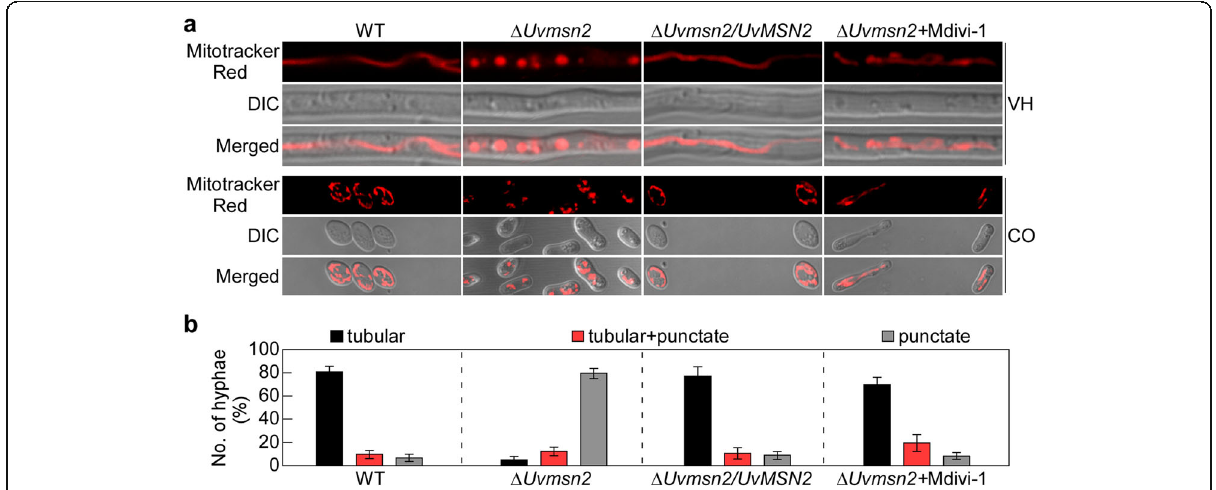
Fig. 6 UvMsn2 is important for the maintenance of mitochondrial morphology in Ustilaginoidea virens . a Confocal microscopic observation of mitochondria in hyphae and conidia of HWD-2, Δ Uvmsn2 and Δ Uvmsn2 / UvMSN2 treated or untreated with Mdivi-1 and stained with Mitotracker Red. VH, vegetative hyphae; CO, conidia. b Statistical analysis of the mitochondrial morphology in the indicated strains. The mean values ± SD were calculated from three independent